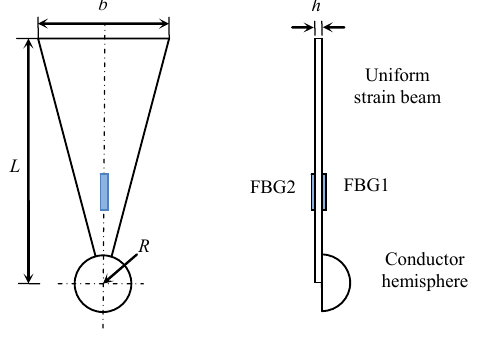
Fig. 9 Structure diagrams of uniforms train beam and twin-FBGs.